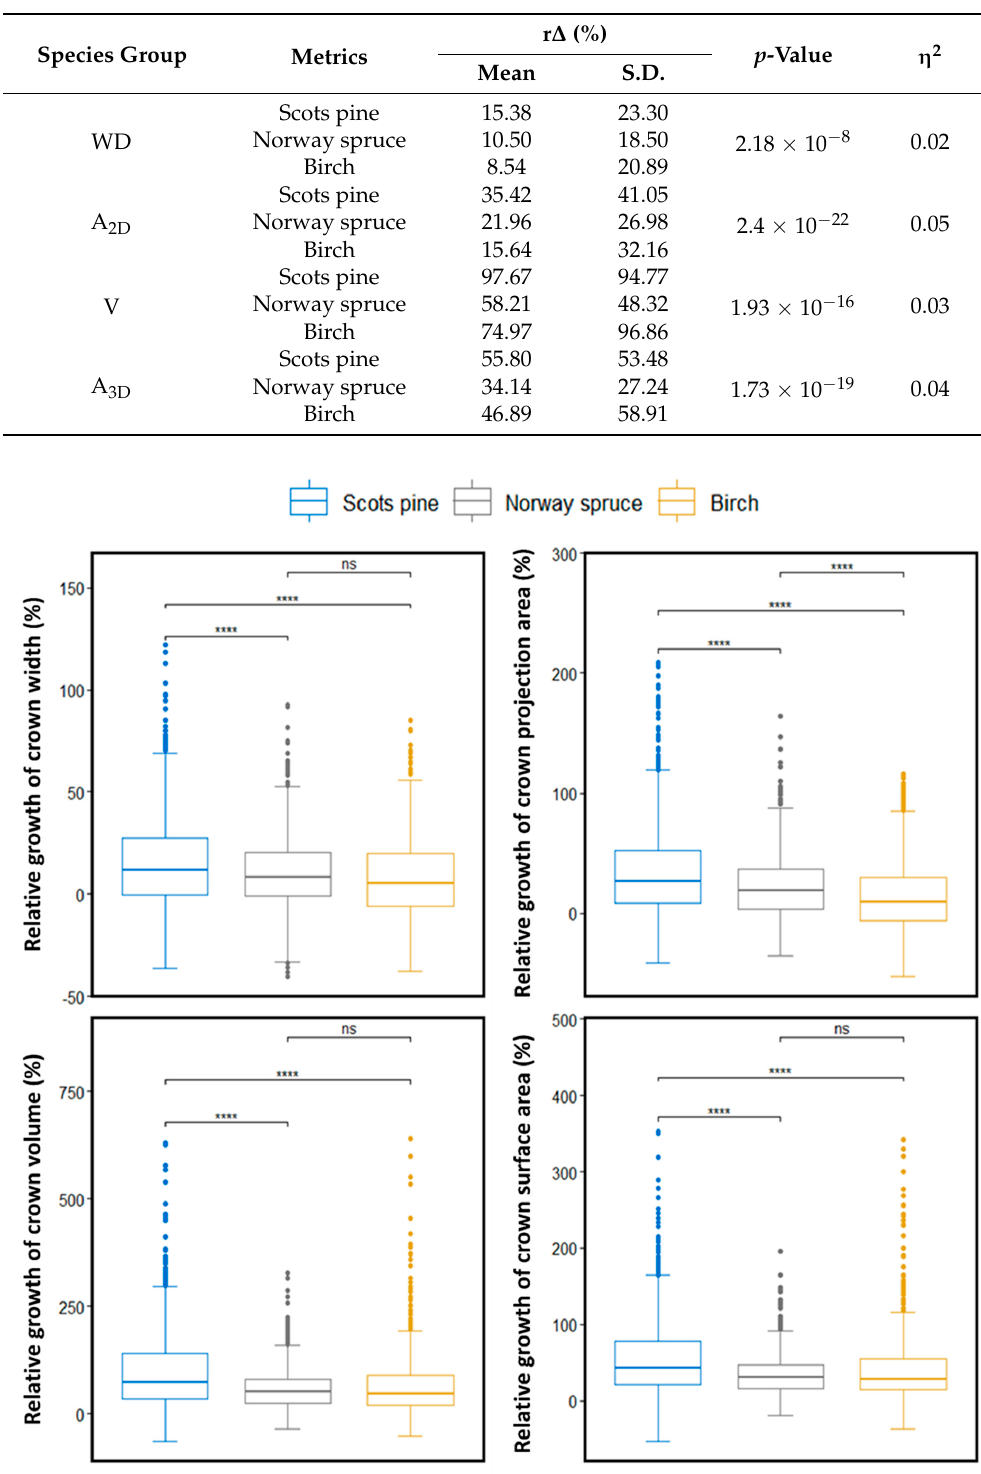
Figure 6. Pairwise comparisons of the relative growth (%) between different species groups. **** and ns (not significant) denote p -value < 0.0001 and >0.05,